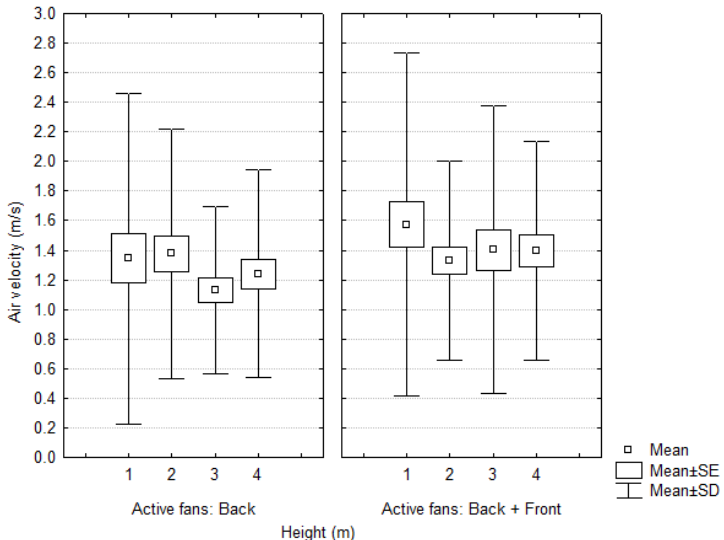
Figure 13. Dynamic test. Air velocity values in function of the number of active fans and the height of measurement. Measurement conditions: distance = 2.5 m; fan blades position = 3.